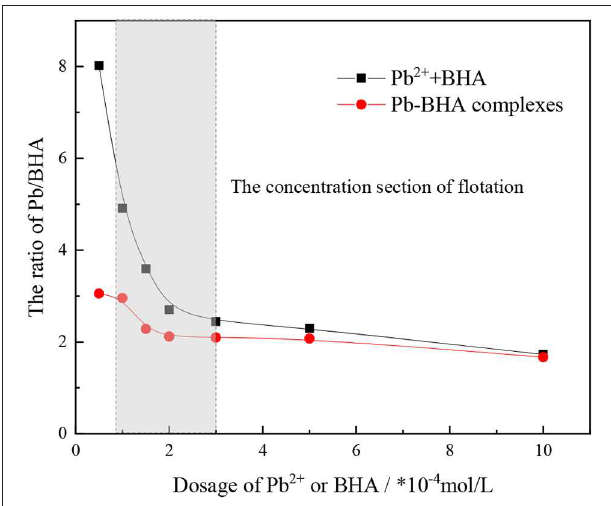
FIGURE 4 | Ratio of BHA and lead ions adsorbed on scheelite surface (pH = 9.0 ± 0.2, C Pb : C BHA = 1).